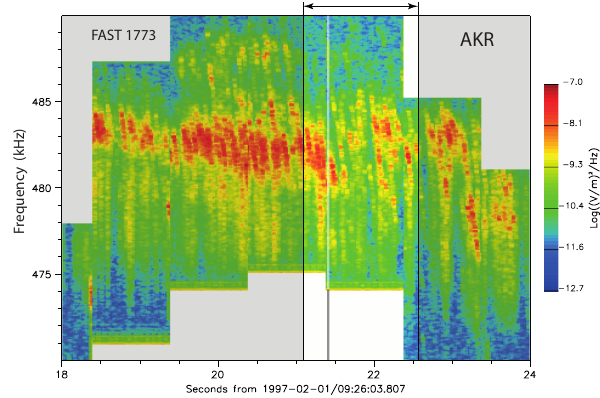
Fig. 2. Six second snapshot of power spectral density of Auro- ral Kilometric Radiation in the highest available resolution (FAST TRACKER instrument). The slice between the two vertical bars in- dicated by the two-sided arrow corresponds to the shaded slice in Fig. 3 and the fully resolved electron data of Fig. 4. The highest available time resolution is ∼ 30ms. The radiation consists of many short lived radiation events of ∼ (1–2)% bandwidth. The highest power flux in these events amounts to P ∼ 10 − 11 Wm − 2 (or energy density W ∼ 10 − 19 Jm − 3 ). In this example the events exhibit nega- tive frequency drifts of df/dt ∼− 100kHzs − 1 with the implication that in this particular case the individual radiation sources move into a region of decreasing magnetic field strength, i.e. upward along the geomagnetic field at velocity 10 3 . V . 10 4 kms − 1 . The shaded narrow vertical slice corresponds to the low-frequency waveform snapshot in Fig.